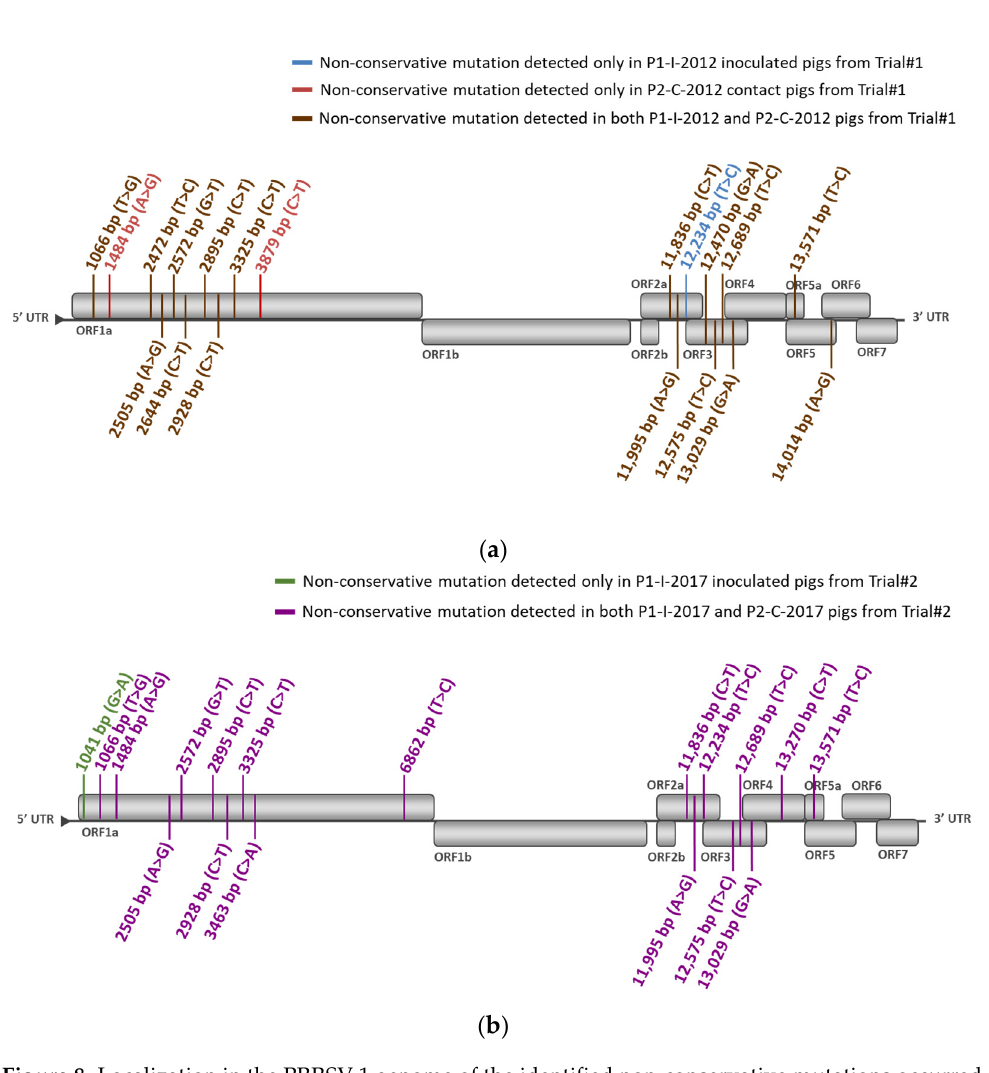
Figure 9. Localization in the PRRSV-1 genome of the identified mutations potentially linked to the adaptation (colored in blue) or the loss of attenuation (colored in red) phenomenon of the Porcilis ® PRRS DV strain after limited passages in pigs during Trial#1 and Trial#2. The KF991509.2 full-ge- nome sequence of Porcilis ® PRRS modified live vaccine of type 1 (MLV1) DV strain is used as refer- ence .